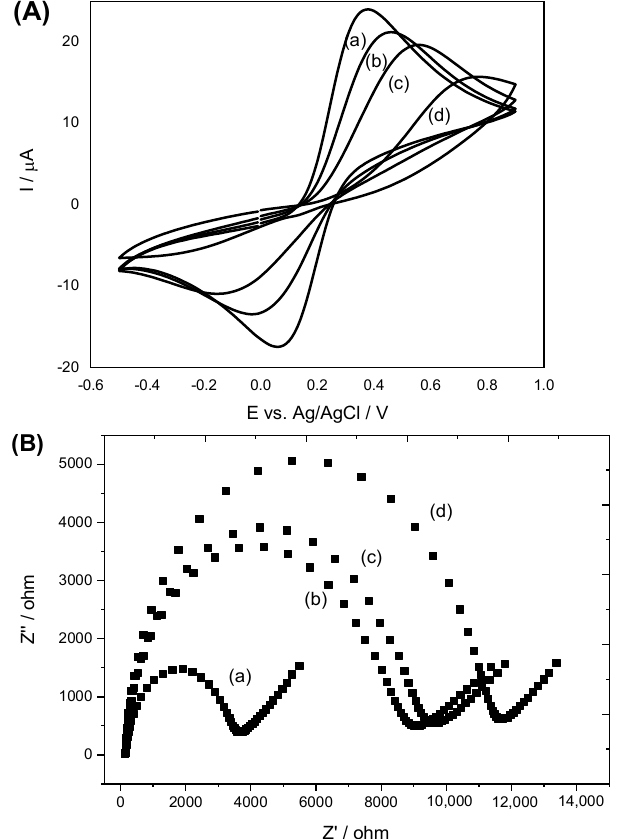
Figure 2. ( A ) CV and ( B ) Nyquist plots related to EIS characterization of (a) CPE, (b) CPE/MWCNTs/IIP–MeHg, (c) CPE/MWCNTs/NIP and (d) CPE/IIP–MeHg applied in 2.5 mmol L –1 IIP-MeHg, (c) CPE/MWCNTs/NIP and (d) CPE/IIP-MeHg applied in 2.5 mmol L − 1 [Fe(CN) 6 ] 3– , [Fe(CN) 6 ] 3– , 2.5 mmol L –1 [Fe(CN) 6 ] 4– and 0.1 mol L –1 KCl. 2.5 mmol L − 1 [Fe(CN) 6 ] 4– and 0.1 mol L − 1